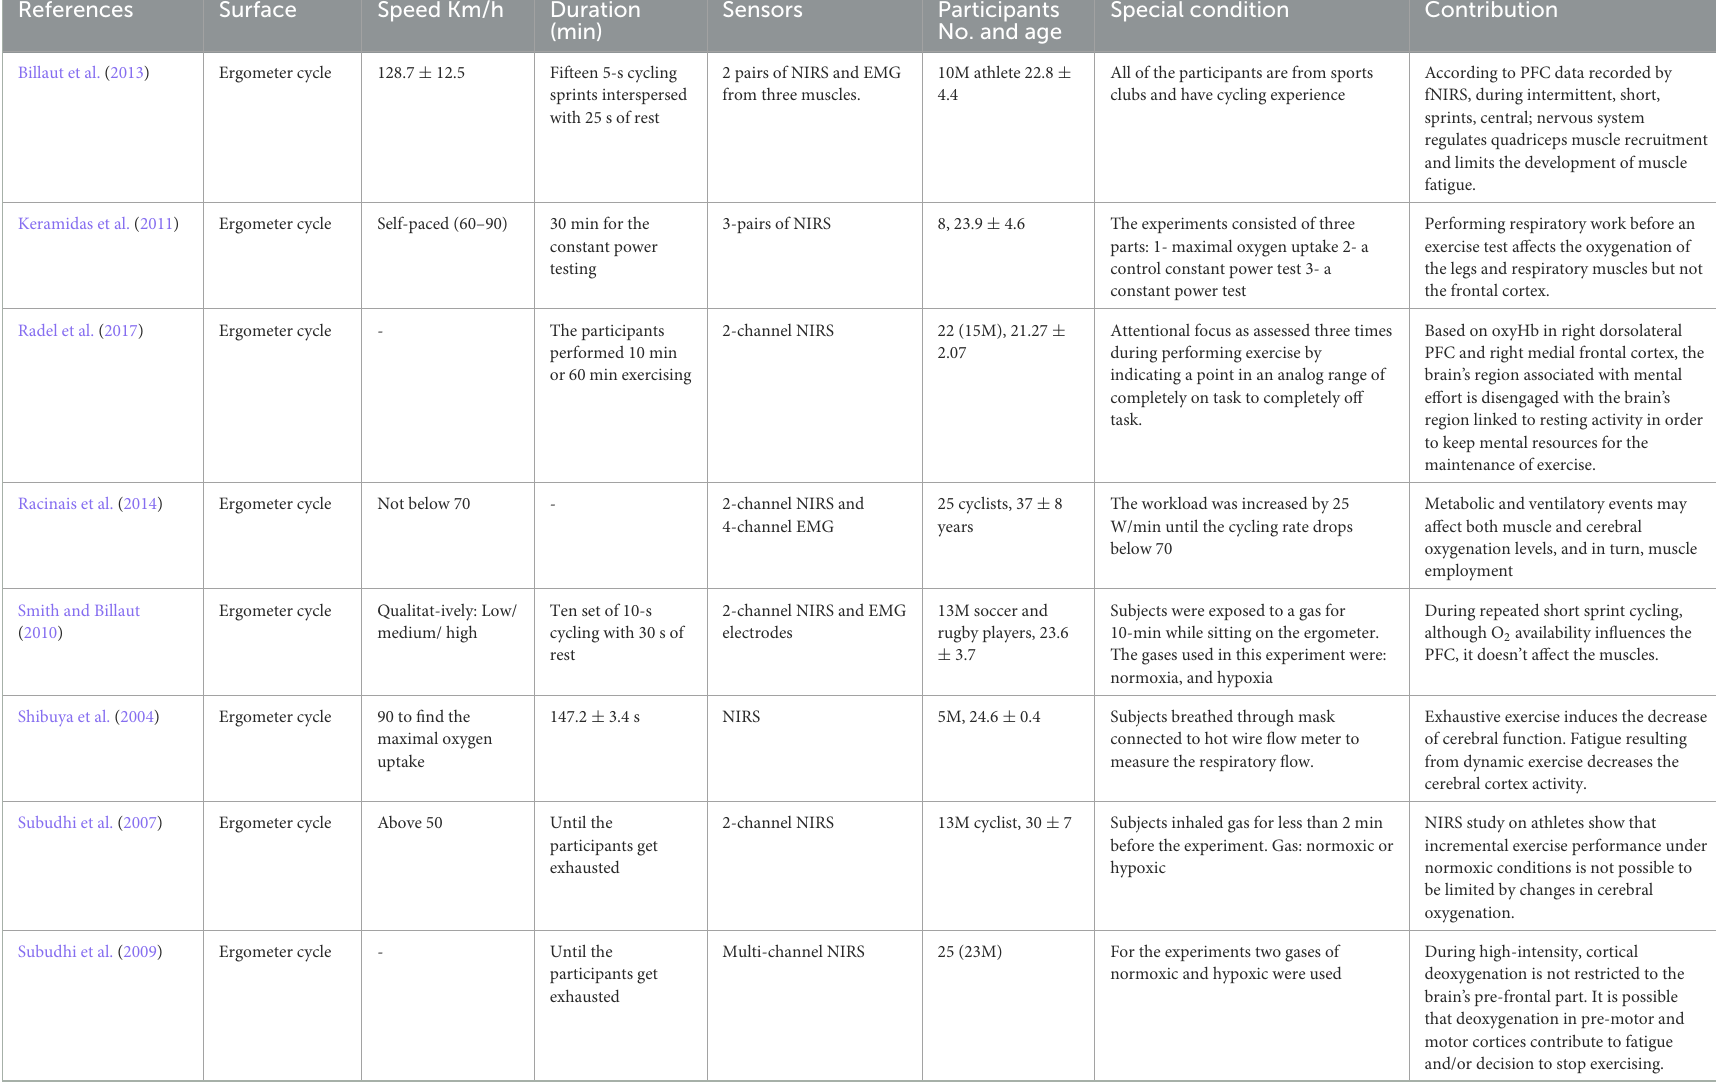
TABLE 4 Brain-body imaging in